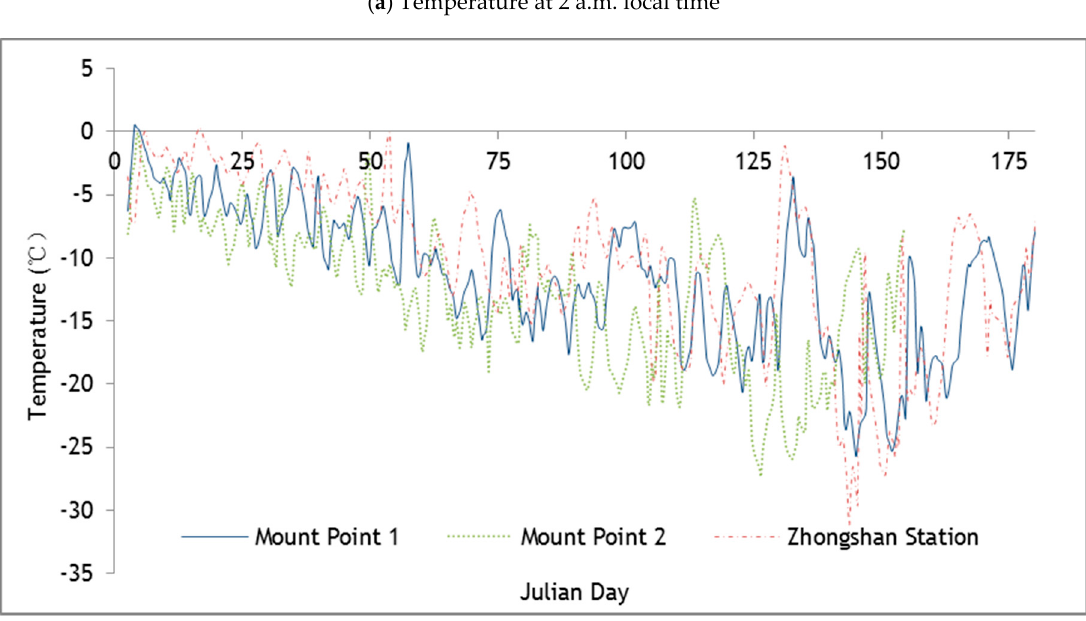
Figure 6. Comparison of the temperature from installation points 1 and 2 and from Zhongshan Station.